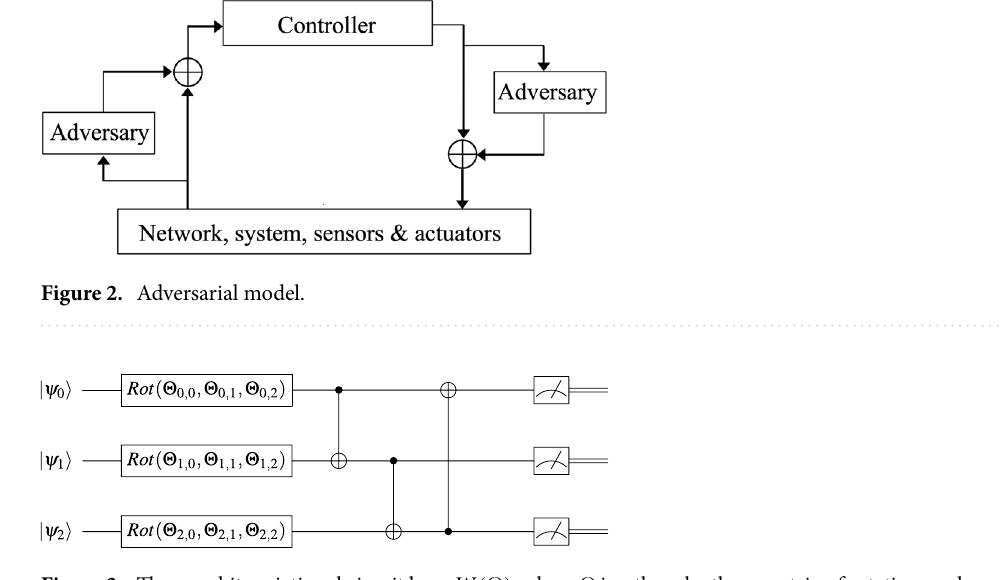
Figure 3. Three-qubit variational circuit layer W (�) , where (cid:31) is a three by three matrix of rotation